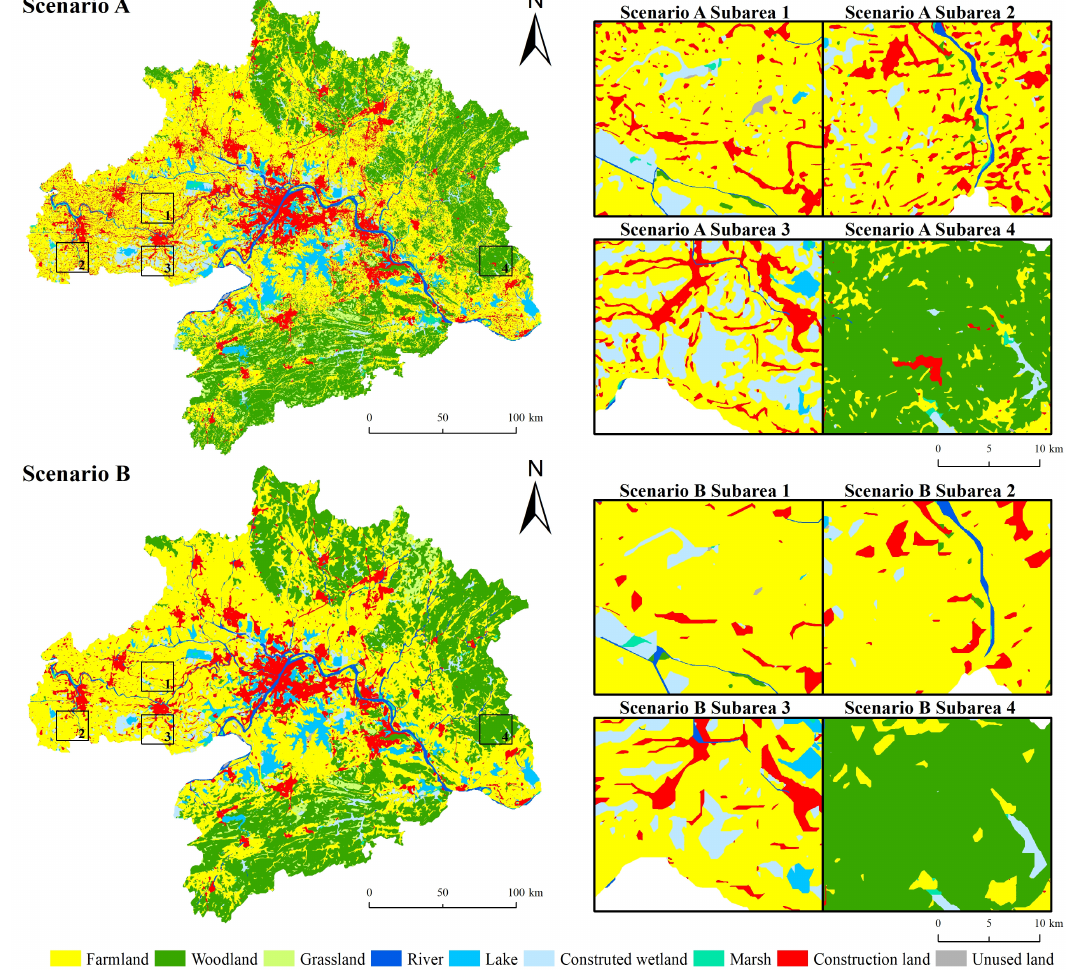
Figure 8. Comparison of Natural Growth ( A ) and Ecological Protection ( B )